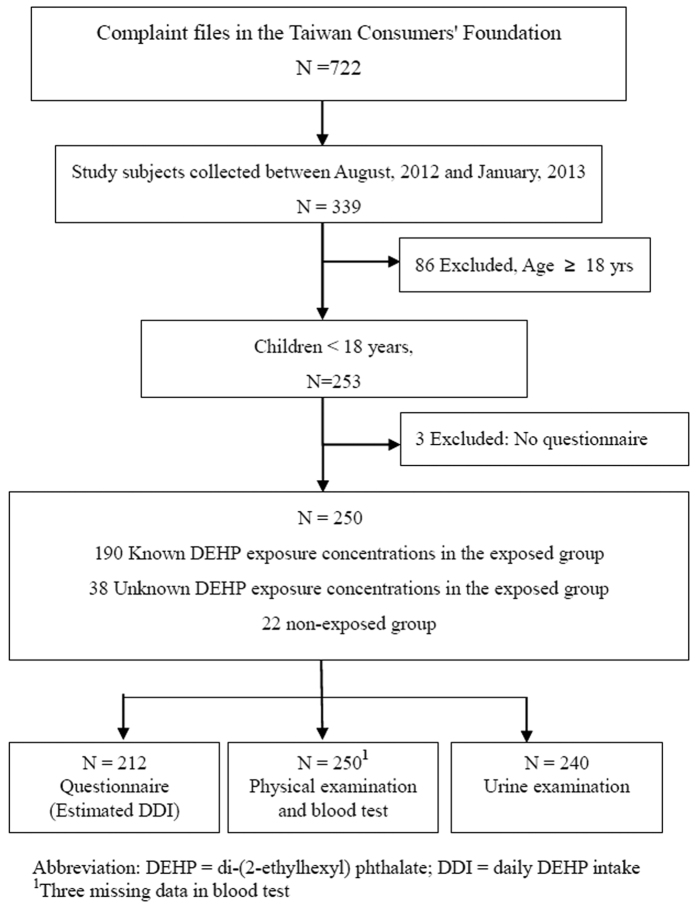
Study flowchart.